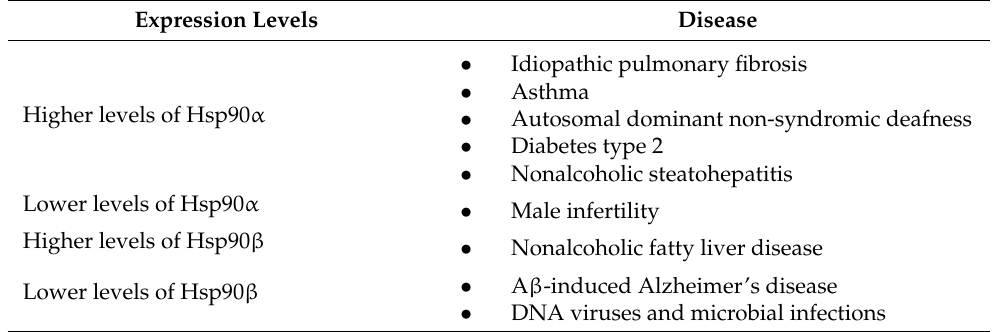
Table 2. Role of specific Hsp90 isoforms in diseases 1 .